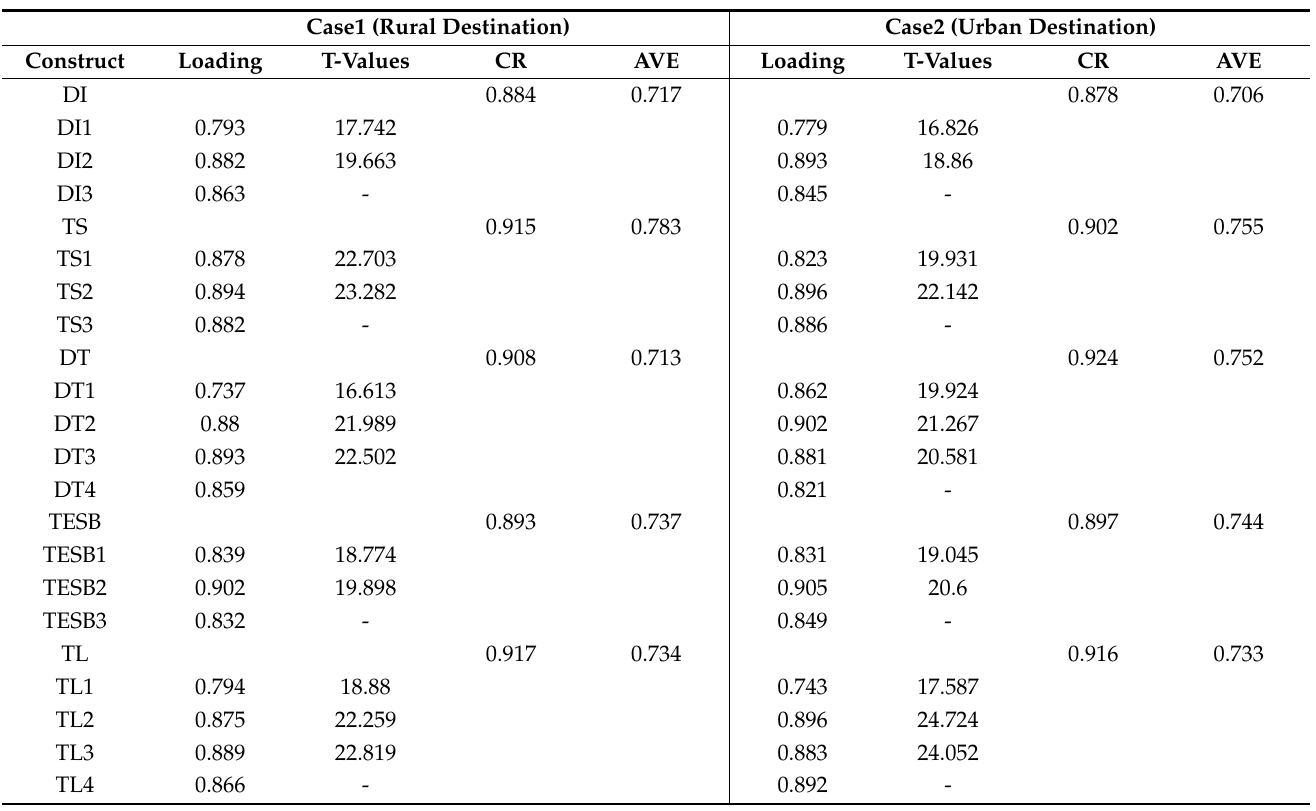
Table 2. Measurement model results.